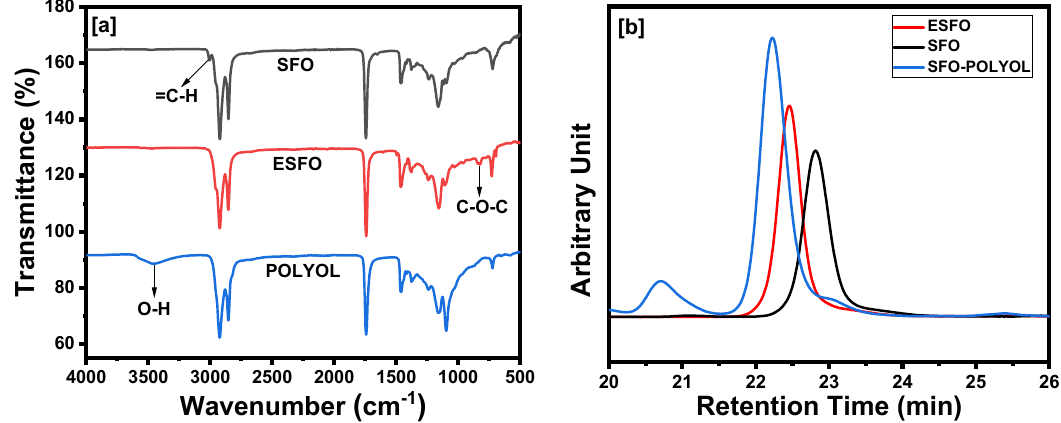
Figure 1. ( a ) FT-IR and ( b ) GPC of sunflower oil, ESFO, and SFO polyol.